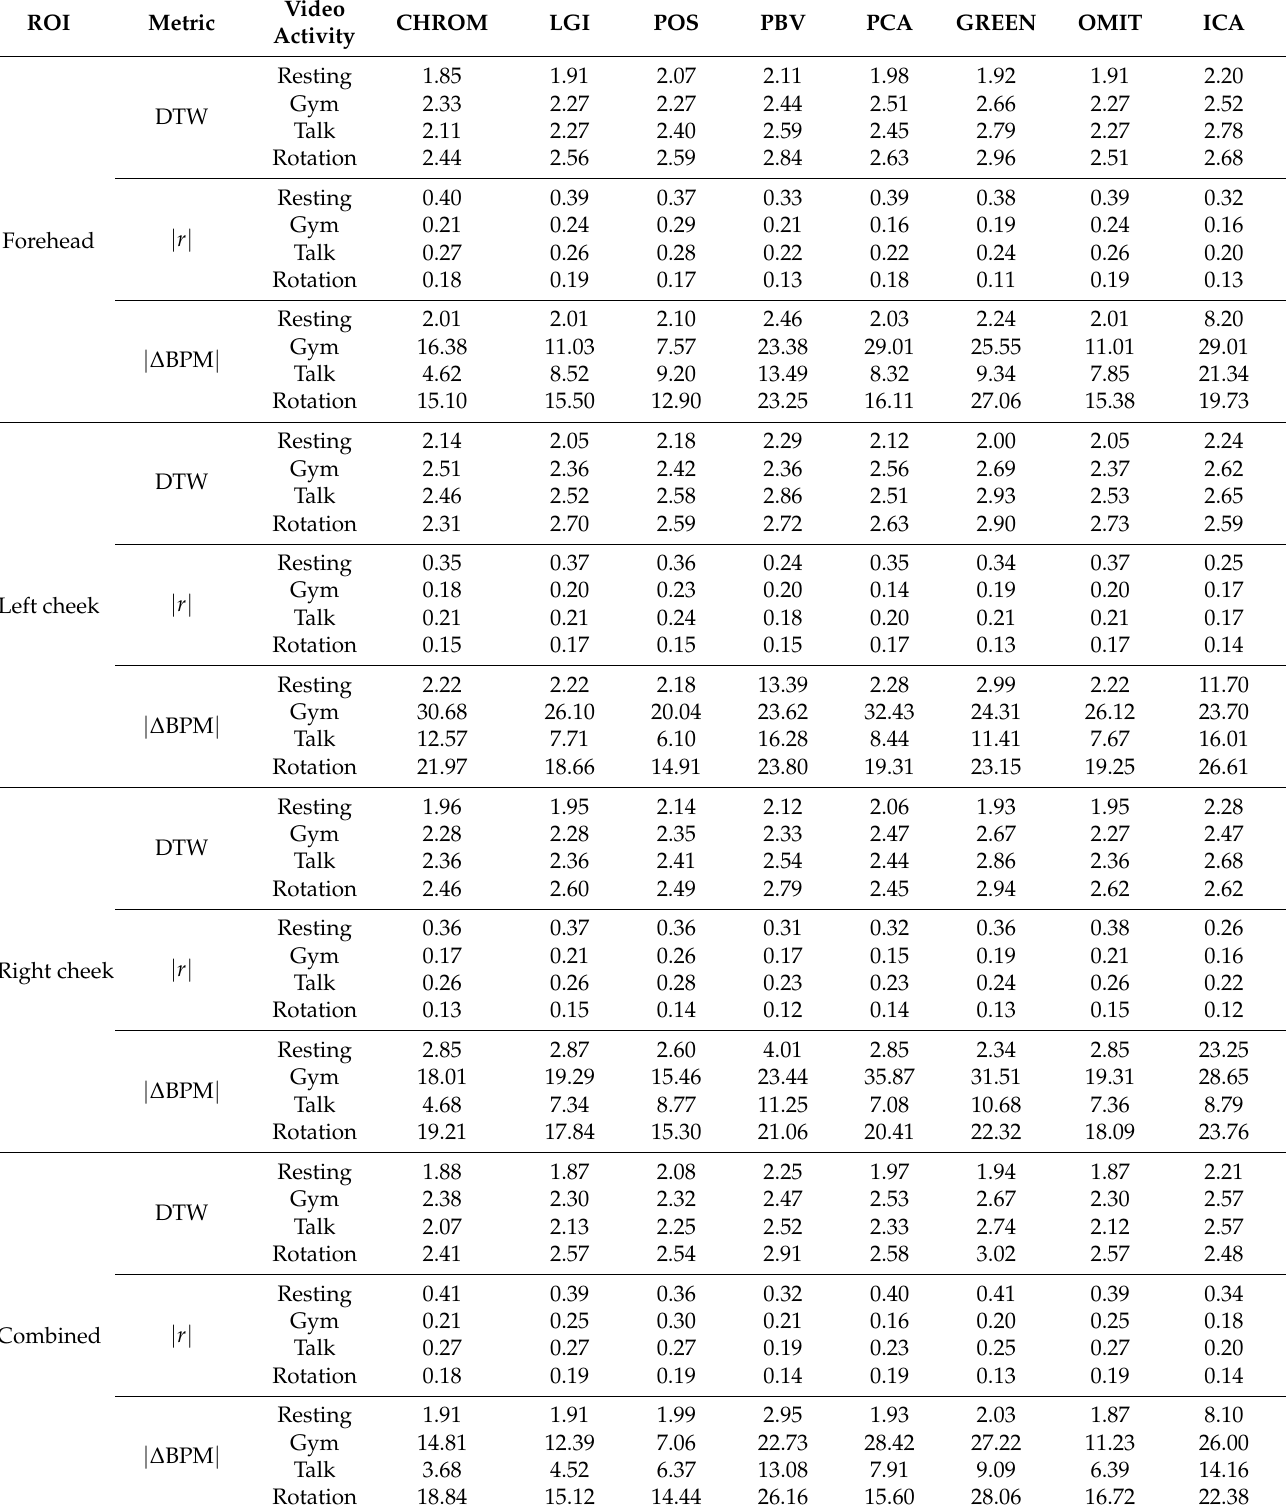
Table 2. Evaluation metric results for constructing rPPG signals using eight methods. BPM = beats per minute, DTW = dynamic time warping, ROI = region of interest, r =